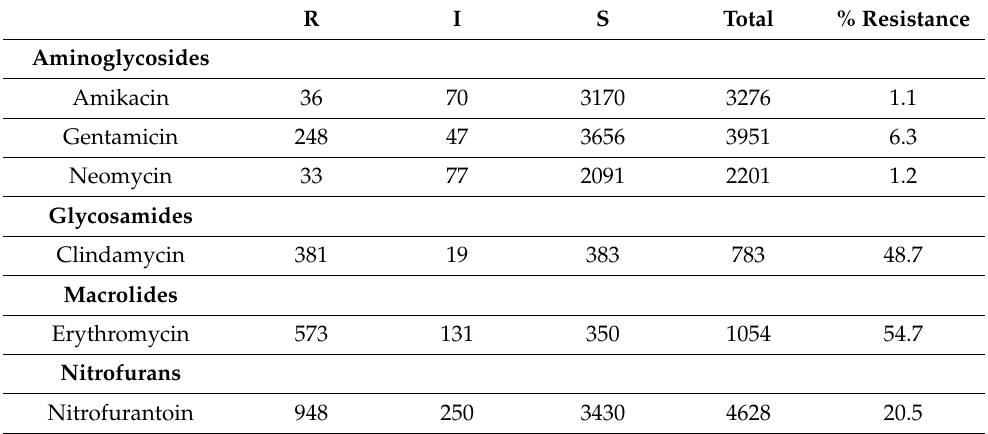
Table 2. The pattern of antimicrobial sensibility in the 5306 isolates between 2017 and 2021 (R—resistant, I—I-intermediate, S—sensible) to aminoglycosides, glycosides, macrolides, and nitrofurans.